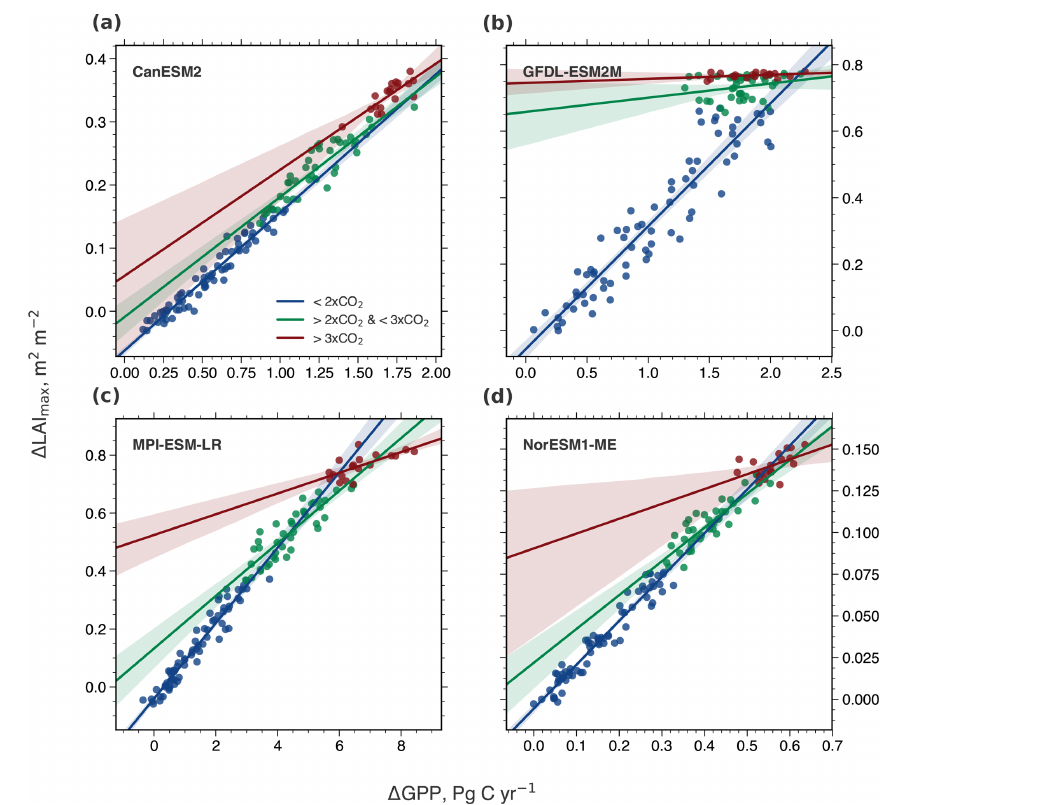
Figure A4. Correlation of (cid:49) LAI max and (cid:49) GPP with increasing CO 2 forcing, starting from a preindustrial concentration of 280ppm (1 × CO 2 ) to 4 × CO 2 (CMIP5 1pctCO2 simulations). Results are shown for four CMIP5 models analogous to Fig. 5. Blue colored dots show the relation between 1 × CO 2 and 2 × CO 2 , green colored dots between 2 × CO 2 and 3 × CO 2 , and red colored dots between 3 × CO 2 and 4 × CO 2 . The respective colored lines represent the best linear fit through those dots and the shading represents the 95% confidence interval.